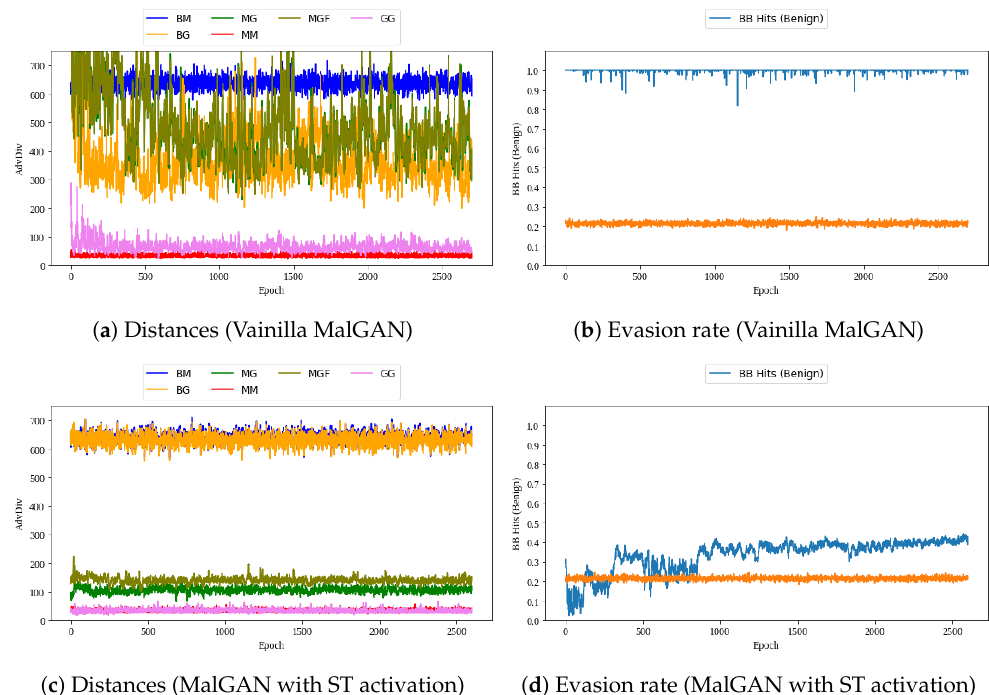
Figure 11. ( Left column) Distances between samples of real and synthetic data distributions: BM (benign and malign data), MG (malign and generated malign data), MGF (malign and generated malign data that fool the black-box model), BG (benign and generated malign data), GG (two samples of generated malign data) and MM (two samples of malign data). ( Right column) Evasion ratios: (blue) generated malign examples (AEs) and (orange) real malign examples that are classified as benign by the black-box model. In all figures, the x-axis represents the GAN training